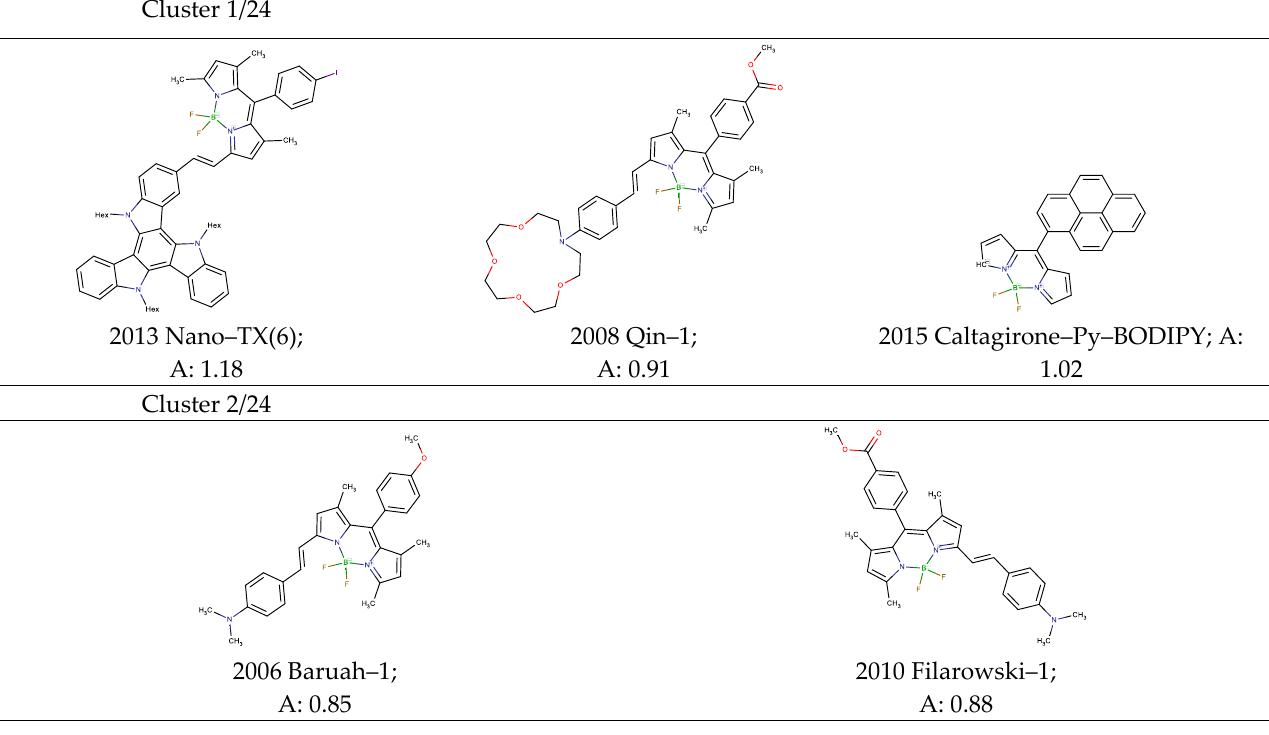
15 of 31 Figure 10. Quantum yield versus Stokes shift diagram in terms of 1000/cm for a 24-cluster dataset of 115 BODIPYs, in decreased order, of parameter A. The diagrams in Figures 9 and 10 (see in particular clusters 1 – 2 and 23 – 24) show reg-